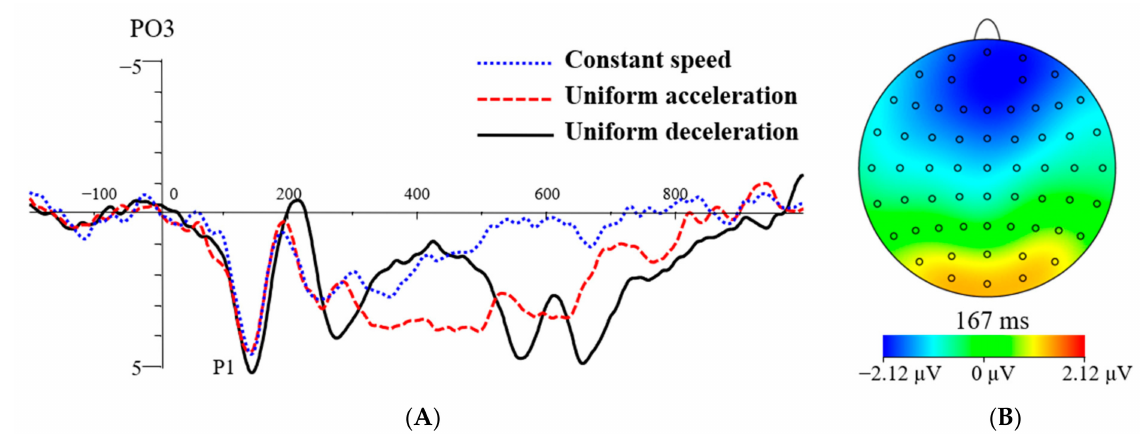
Figure 4. The grand average waveform for P1 at speed types of CS, UA, and UD ( A ). The topographic map illustrates the difference in P1 between the UD and UA ( B